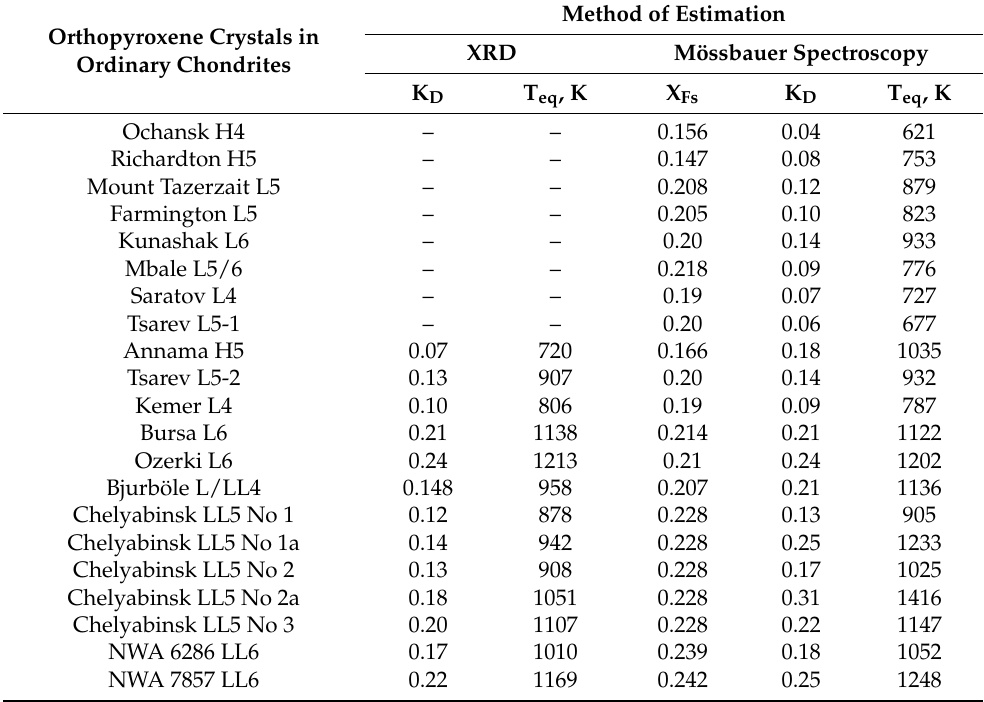
Table 3. The values of the distribution coefficient and the temperature of equilibrium cation distribu- tion in in orthopyroxene crystals in ordinary chondrites determined by means of X-ray diffraction and Mössbauer spectroscopy (data were taken from References